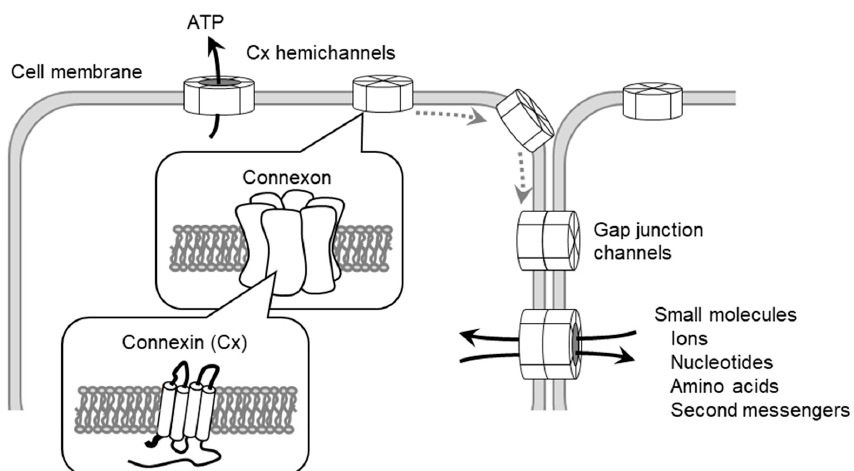
Figure 1. Gap junctions (GJ) and connexin (Cx) hemichannel-mediated intercellular (Cxs are inserted